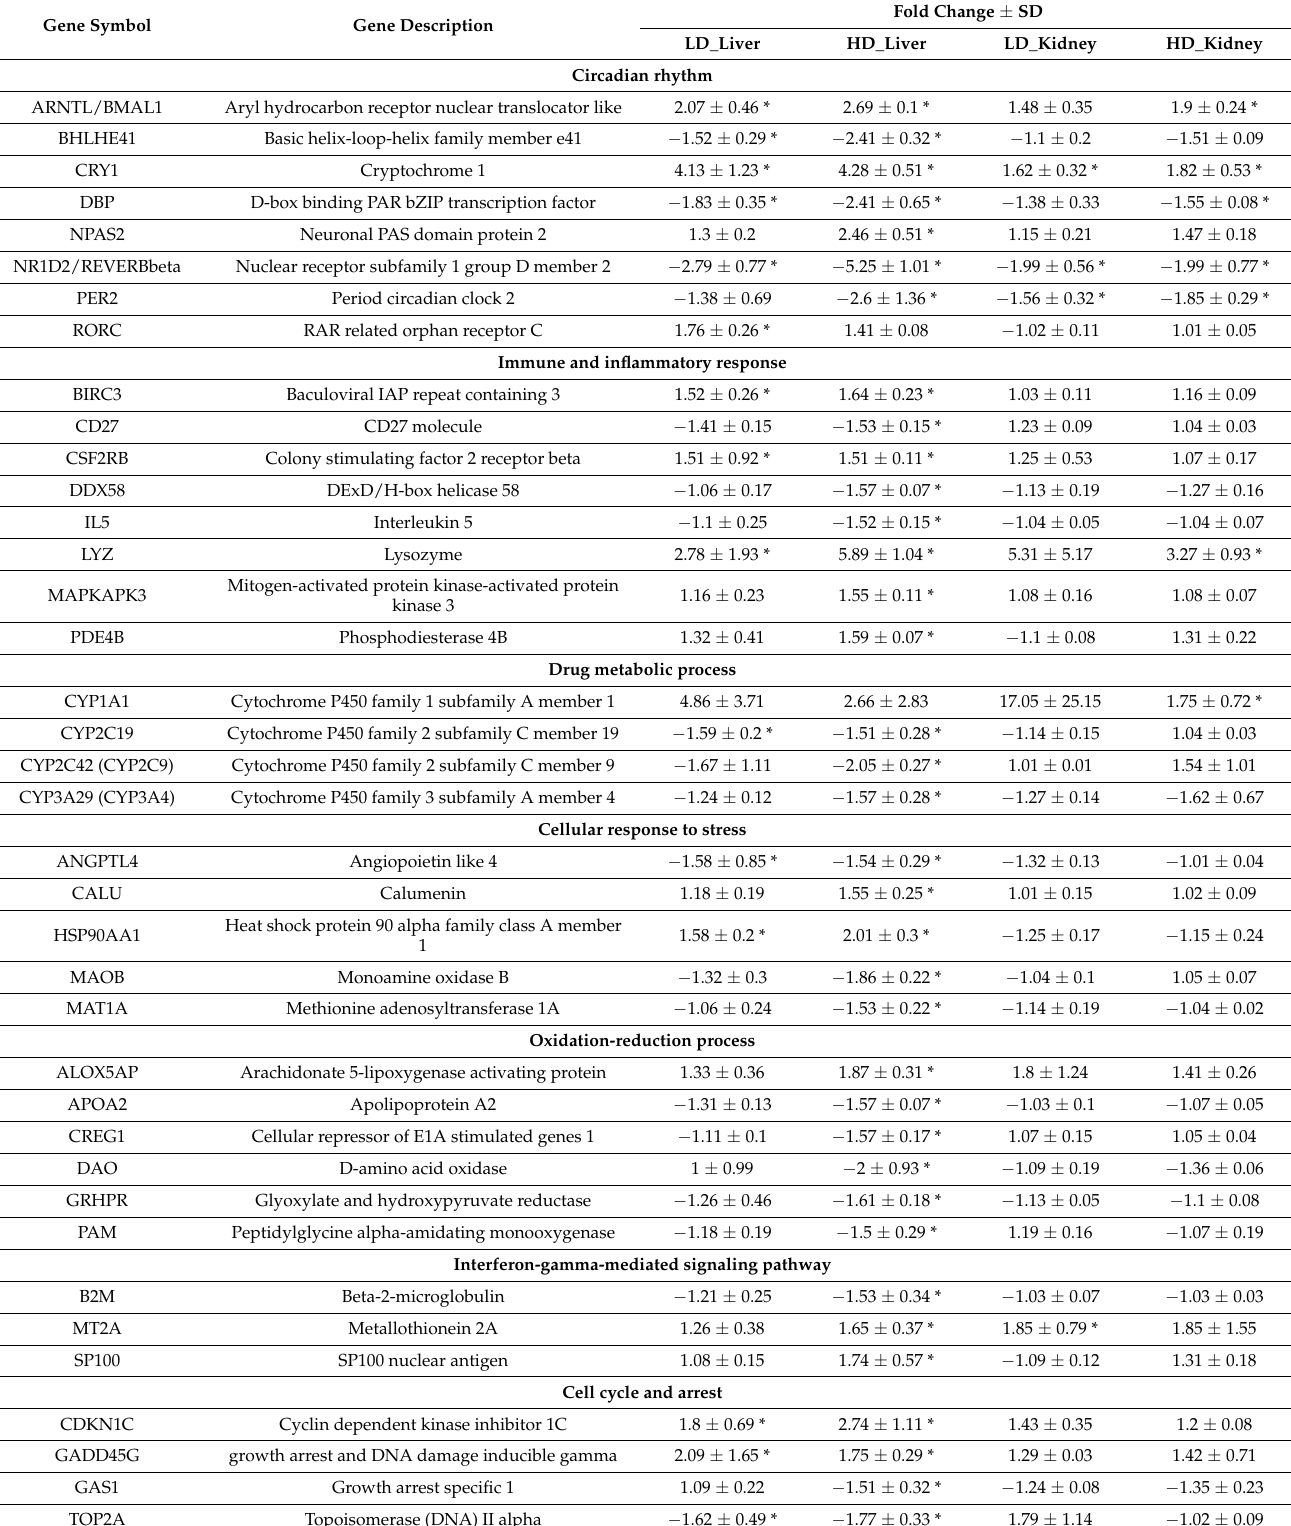
Table 5. Differentially expressed genes targeted by the glucocorticoid receptor (GR) in the liver. The target genes of GR were retrieved from TransFac, Harmonizome, GeneGlobe and TRRUST databases and compared to the DEGs of the liver. A total of 64 hepatic DEGs are considered bona fide targets of GR and are compiled based on their biological functions. * Differentially expressed genes (Foldchange > ± 1.5, p -value < 0.05 and FDR <